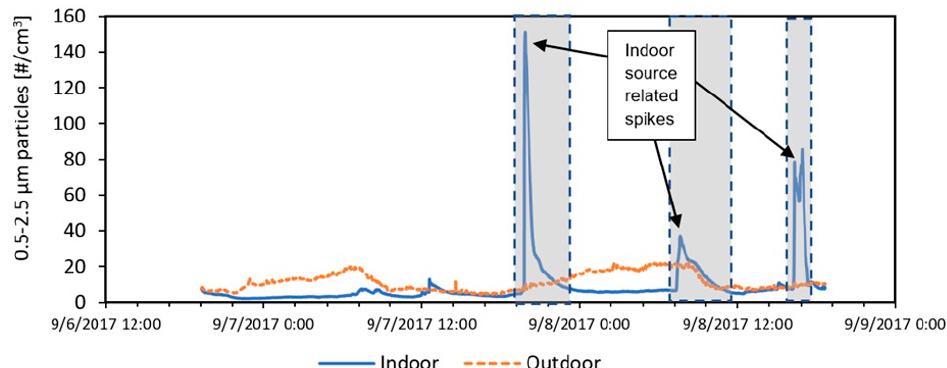
Figure 1. Example from one study home showing the data filtration process. Raw time series data from the shaded regions were removed, and the remainder of the time series was treated as “filtered data”.